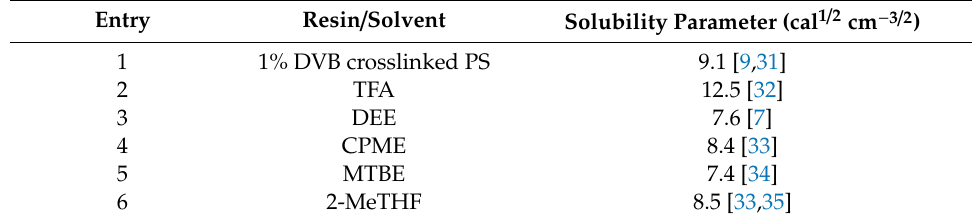
Table 1. Solubility parameters of 1% DVB crosslinked polystyrene (PS) and the ethers used in this study.